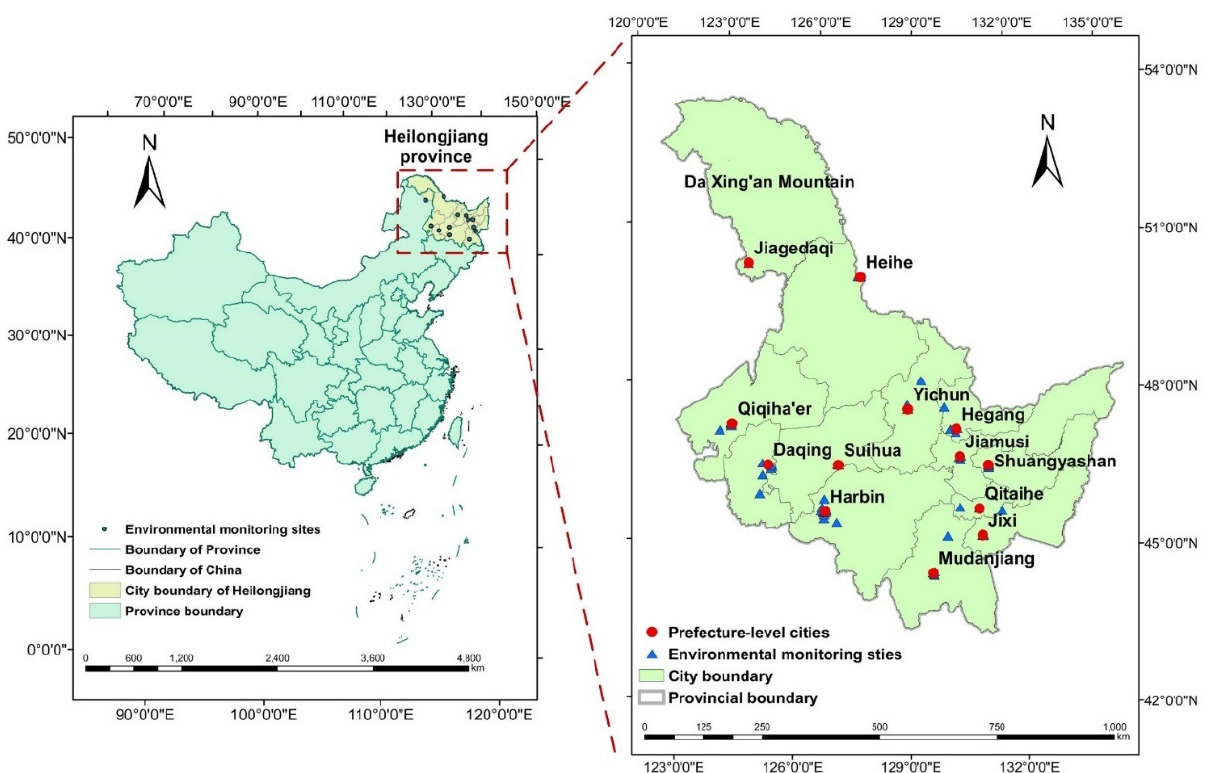
Figure 1. The location of Heilongjiang Province, People’s Republic of China (containing the Da Xing’an Mountain, Drawing review No: GS (2020)4619). Note: Jiagedaqi is a special residential